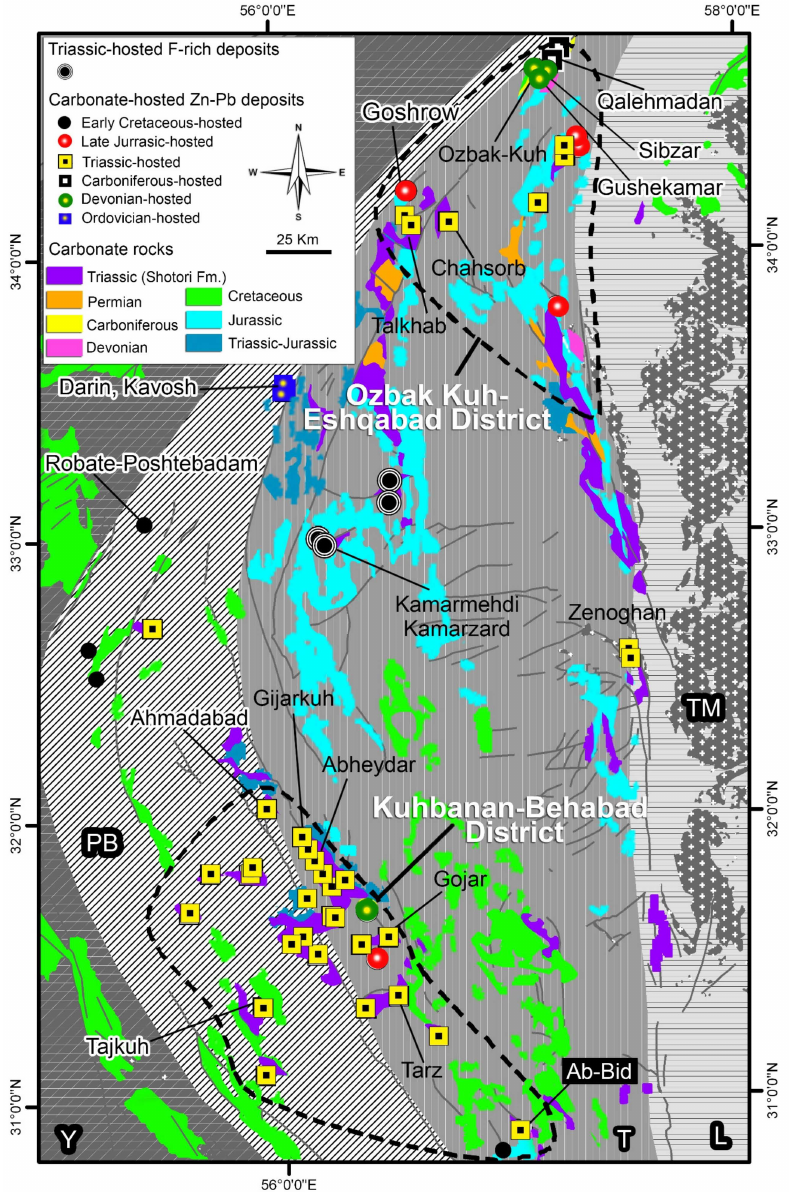
Figure 2. Distribution map of carbonate-hosted MVT and F-rich deposits in the Tabas-Posht e Badam metallogenic belt. Note the host rock age of MVT deposits (modified after [4]). Key: L, Lut Block; PB, Posht-e-Badam Block; T, Tabas Block; TM, Tertiary magmatic rocks; Y, Yazd Block. The Early Jurassic rock unit (J Shssh ) is composed of dark grey sandstone, shale, and a conglomerate of the Semshak series. This unit is overlain by gypsiferous marl and gypsum of the J Shmg unit (Figure 3), and by the Upper Jurassic plant fossil-bearing red sandstone, shale, and microconglomerate of the Garedu (J Gsc ) Formation. The faults in this area are categorized into two different systems. The first system is a group of NW– SE-trending strike-slip and reverse faults that dominate in the mine area (Figure 3), and the mineralization is related to these faults. The second includes a set of NE–SW trending strike-slip faults with slight